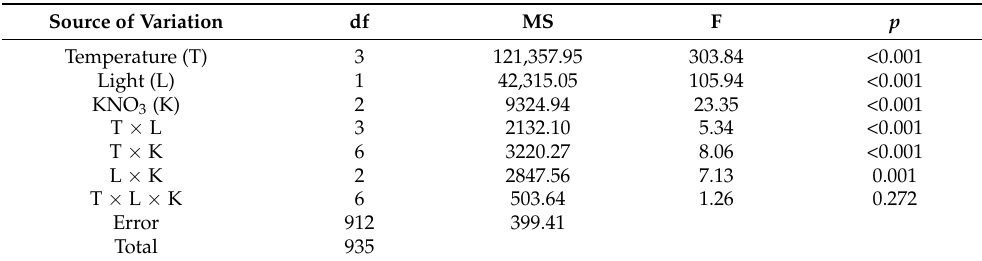
Table 1. Analysis of variance of germinative capacity (GC) of S. lanceolatum affected by temperature regimes (15/6 ◦ C, 20/10 ◦ C, 30/15 ◦ C, and 35/20 ◦ C), KNO 3 concentration (0 mM, 5 mM, and 50 mM) and light regimes (14 h light photoperiod and total darkness).